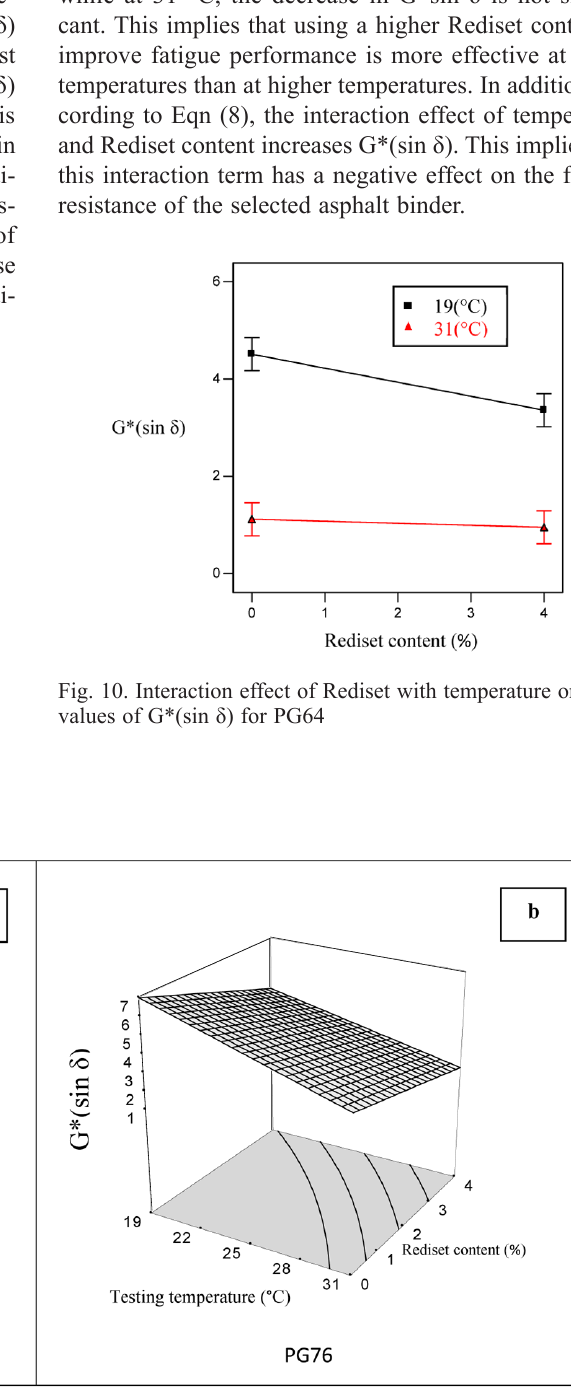
Fig. 9. Plot of response surface for G*(sin δ) values for long-term aging